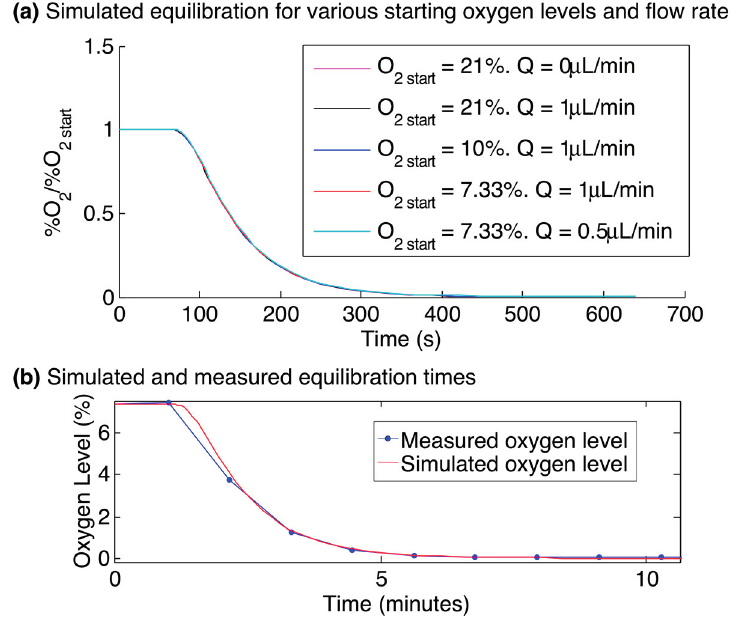
Figure 7. Simulated and experimental oxygen equilibration times within the multilayer microfluidic device. ( a ) Time-dependent simulation results, showing the oxygen level at the centre of the cell culture channel after the oxygen level supplied to the gas control channels L1GL, L1GR, and L3G was switched from O 2 start to 0% at time 60 s, for values of O 2 start ranging from 7.33% to 21%, and flow rates Q ranging from 0 to 1 µL/min. Neither the O 2 start nor Q significantly affected the equilibration curves (e.g., the oxygen level at time 530 s only varied by 0.3% of O 2 start between all of the simulations, with the flow rate showing no effect on the curves, and the curves for O 2 start = 7.33% and 21% reaching 0.5% and 0.2% of O 2 start , respectively at t = 530 s); ( b ) Simulation and measurement of the oxygen levels within the oxygen control device, after the input gas level changed from 7.33% to 0% oxygen at